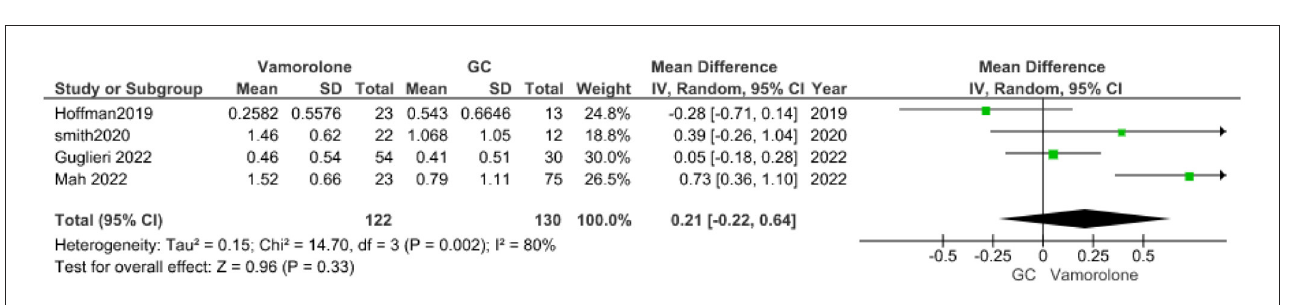
FIGURE9 BMI z score outcome vamorolone vs.